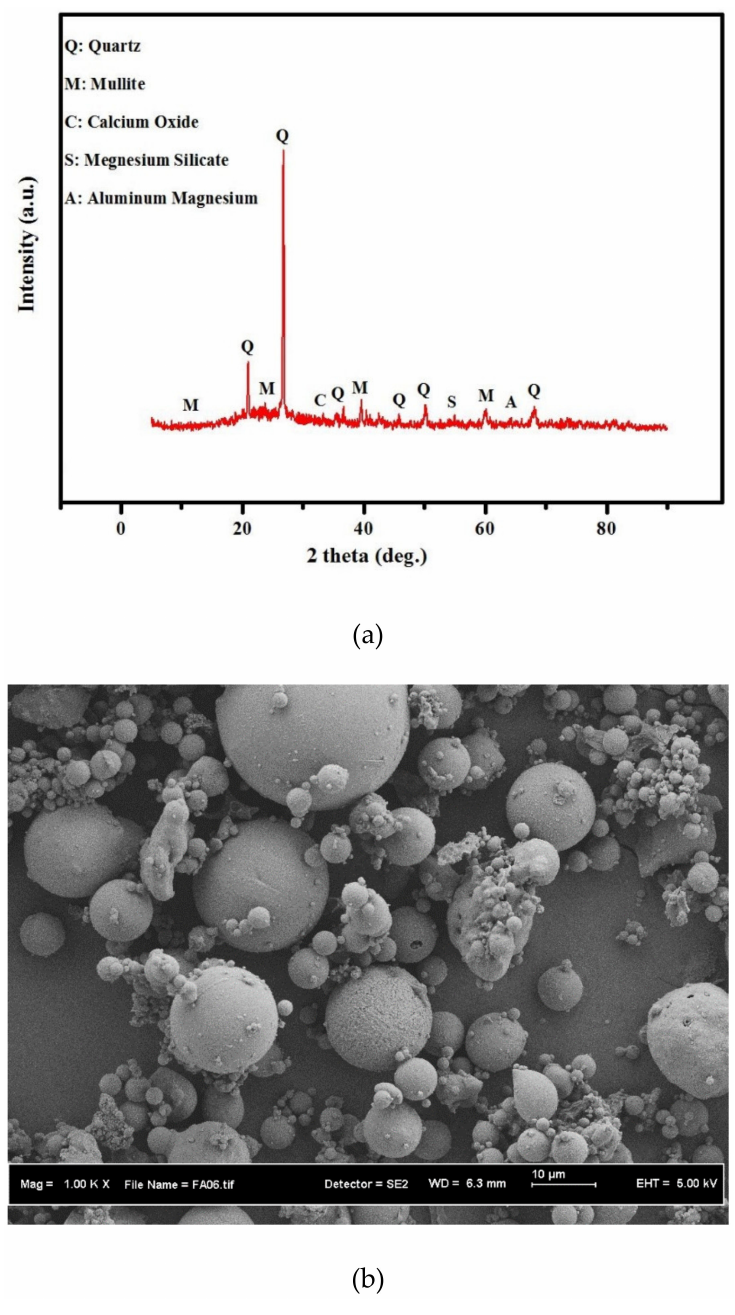
Figure 2. Mineral properties of FA powder ( a ) XRD profile and ( b ) SEM